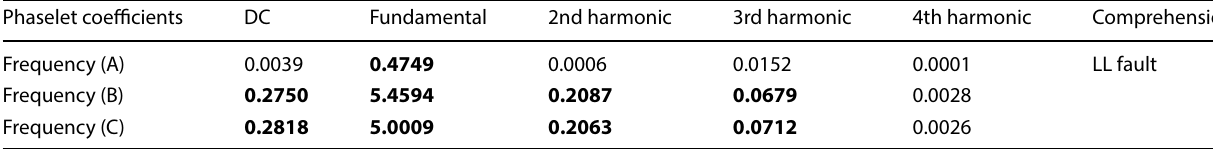
Table 3 Phaselet coefficients under ll